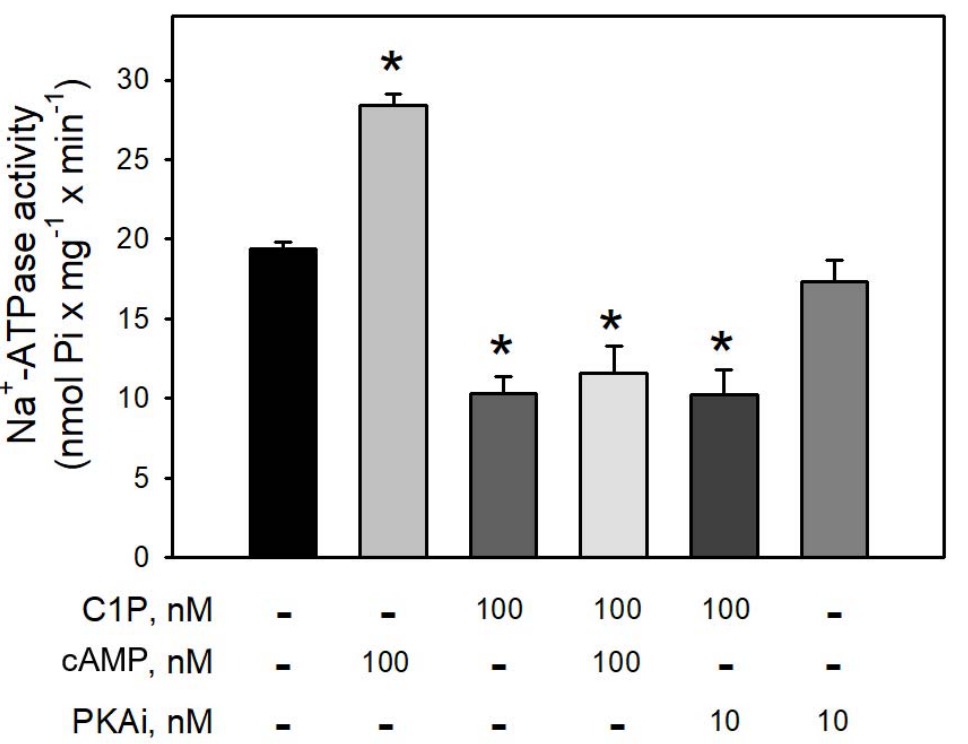
Figure 4. The PKA inhibitor (5–22 peptide) was not able to prevent the inhibition of Na + -ATPase activity by C1P. Na + -ATPase activity was measured as described in the Material and Methods. The assays were carried out in the presence of 100 nM C1P, 100 nM cAMP, and 10 nM PKA i (5–22 peptide) individually tested or in the combinations shown on the abscissa. Data are expressed as means ± SE of at least six experiments conducted in triplicate with BLM from different kidney preparations. * Statistically different when compared to the control ( p < 0.01).